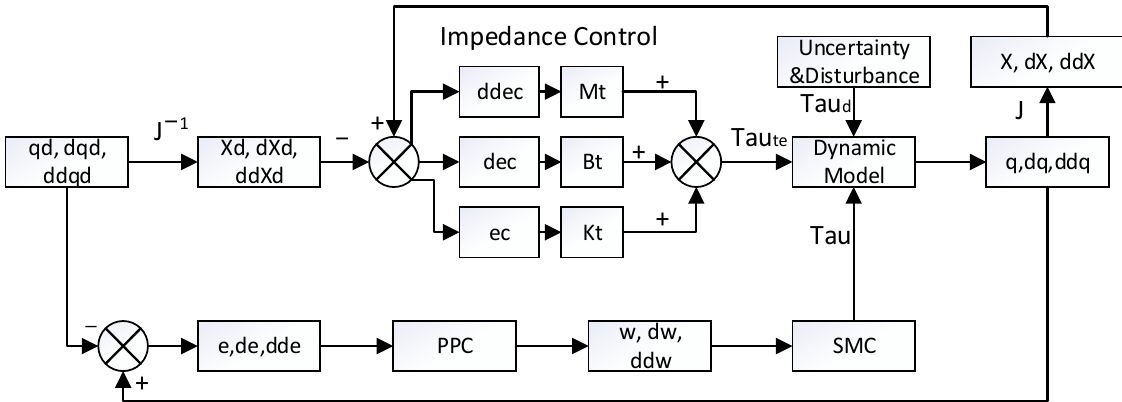
Figure 2. The control structure of space robot system.